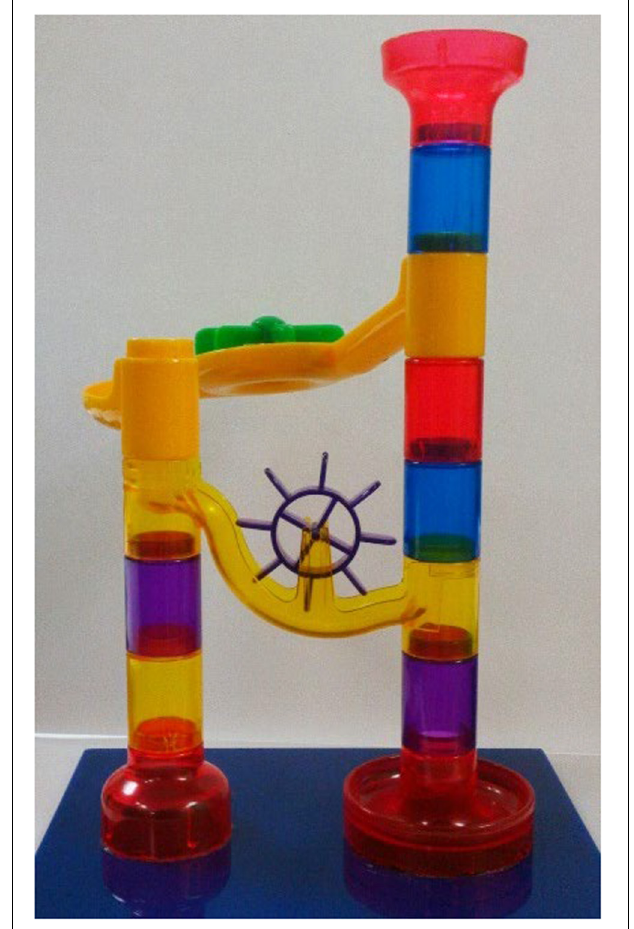
FIGURE 2 | Marble maze used in the